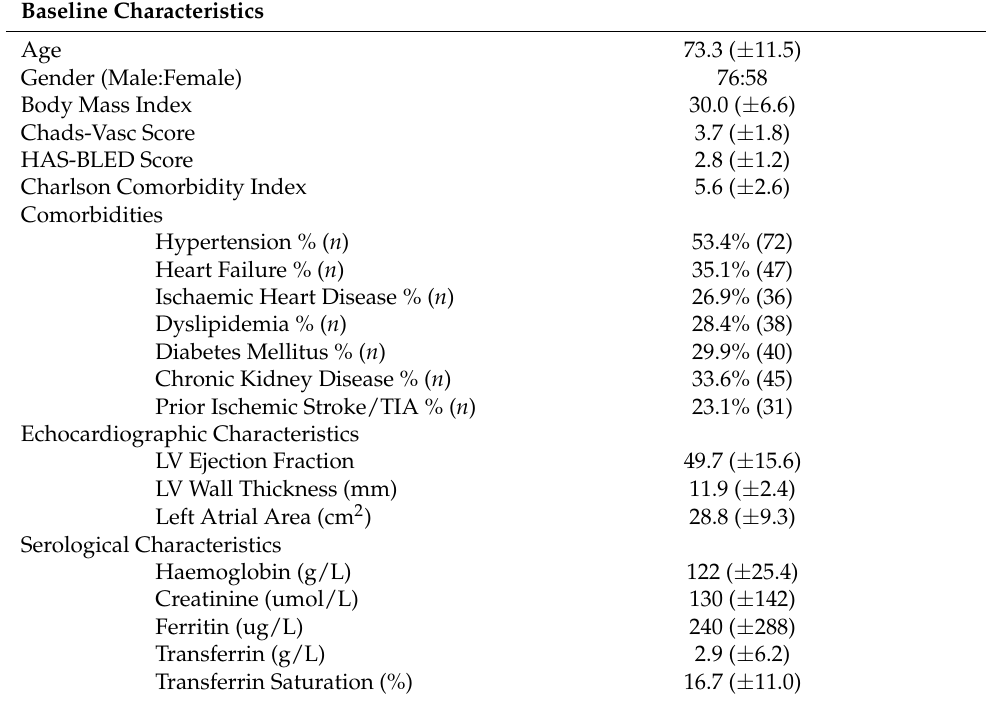
Table 1. Baseline Clinical, Echocardiographic and Serological